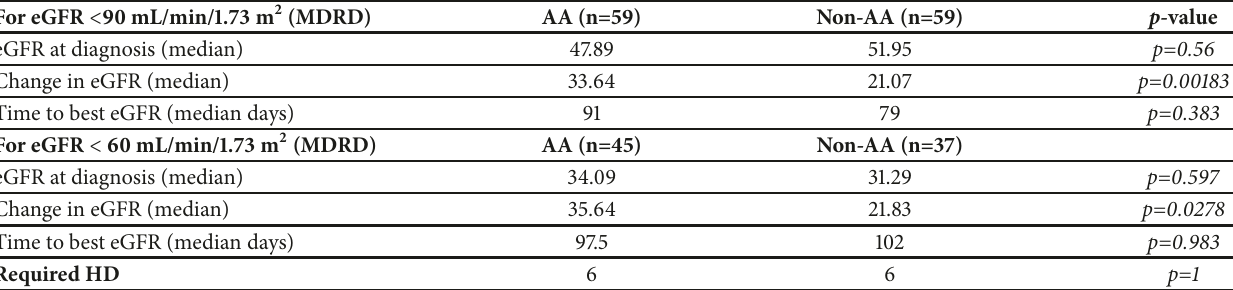
Table 3: Renal response following initial therapy for newly diagnosed multiple myeloma.